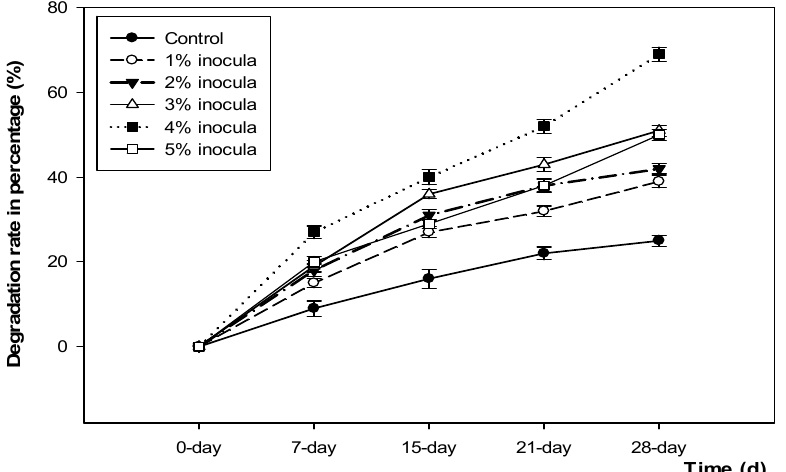
Figure 8. The degradation rate of food waste in a 28 day period was tested by 1% to 5% the culture of bacterial strain FW2 inoculated compared to control without bacterial inocula at pH 7 at a temperature of 14–16 °C. Experiments were performed in triplicate.